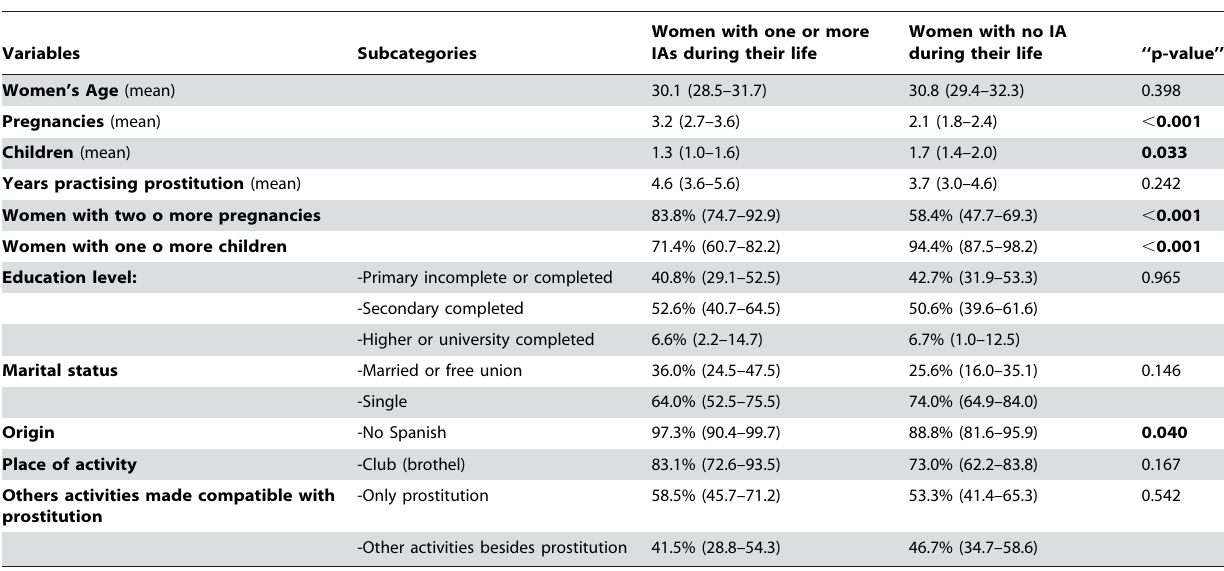
Table 2. Socio-demographic variables and variables related to prostitution in women, according their history of IA.